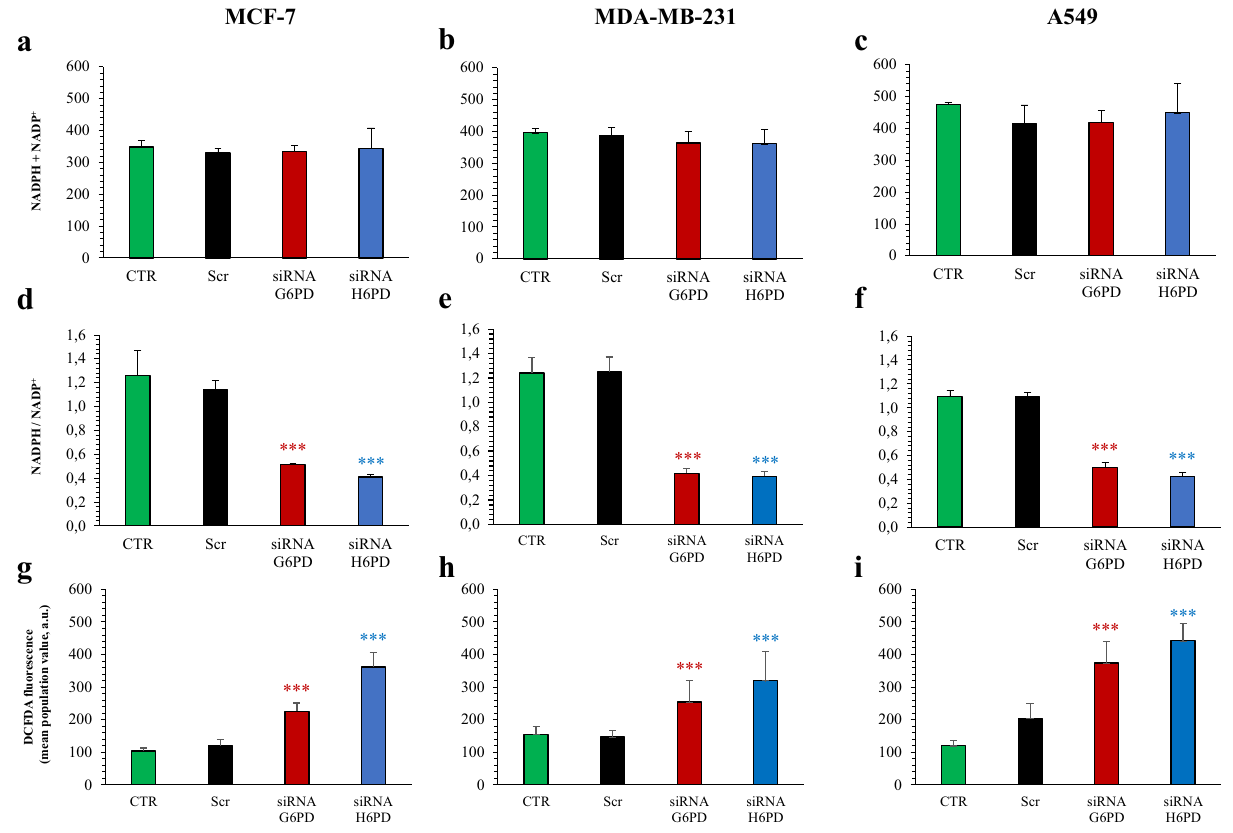
Figure 5. Effect of G6PD and H6PD silencing on cell redox status. Total NADPH + NADP content was similar in MCF-7 ( a ), MDA-MB-231 ( b ) and A549 ( c ) under control condition (CTR, green), scramble siRNA (Scr, black), siRNA G6PD (red) and siRNA H6PD (blue). By contrast, NAPDH/NADP + ratio was significantly decreased by either G6PD or H6PD silencing in all three cell lines ( d – f ). This response was paralleled by an opposite behavior of ROS cell content that was instead significantly increased by both gene silencing ( g – i ). Data are expressed as mean ± SD. ***p < 0.001 vs corresponding